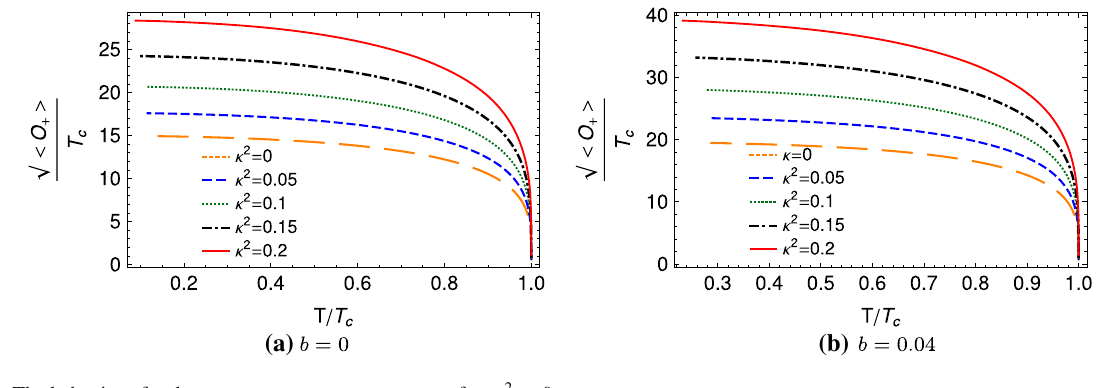
Fig. 1 The behavior of order parameter versus temperature for m 2 = 0